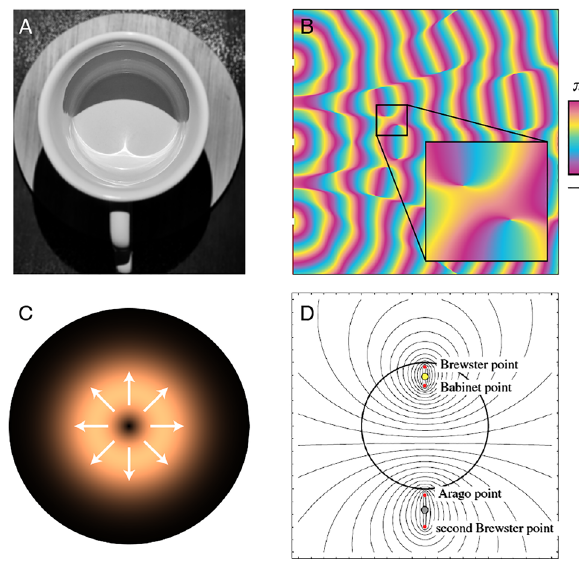
Figure 1: Examples of optical singularities. (A) Cusp-shaped causticina teacup.(B)Phasesingularityinathree- pinhole diffraction. (C) Vector polarization singularity for the TM 01 waveguide mode. (D) Line- fi eld polarization singularities in clear sky. The image (B) is reproduced from Ref. [14], and the image (D) is adapted from Ref.